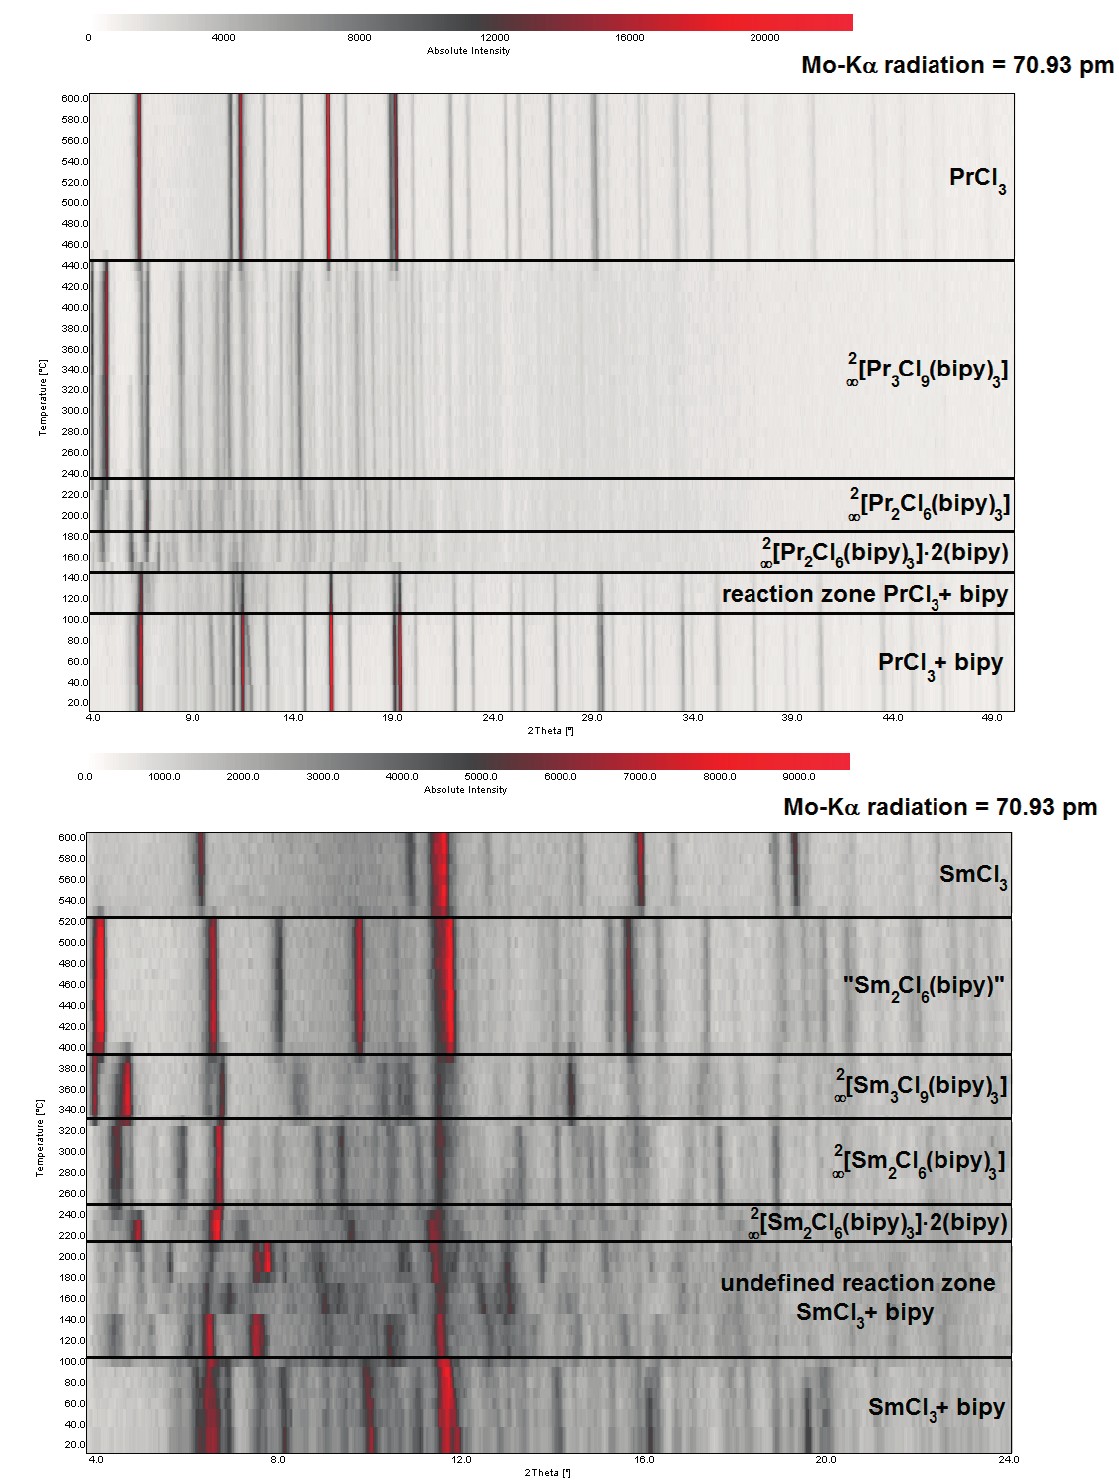
Figure 6. Temperature dependent XRPD investigation of the reaction between PrCl 3 ( top )/SmCl 3 ( bottom ) and 4,4 ′ -bipyridine, illustrating the temperature dependent formation conditions of several coordination polymers and MOFs and the reformation of crystalline LnCl 3